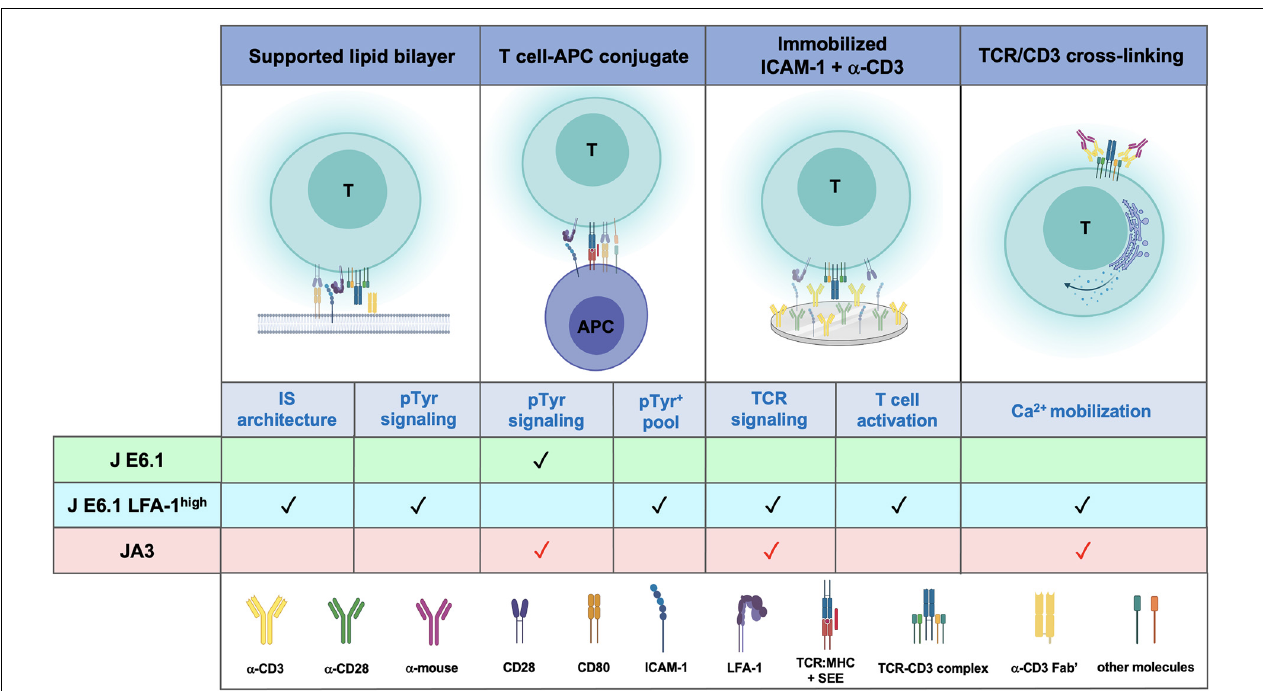
FIGURE 6 | Comparative performance of E6.1, E6.1 LFA-1 high and JA3 cells in IS architecture, TCR signaling and T-cell activation. Schematic representation of experimental settings used for testing the performance of the three Jurkat lines. The symbol “ (cid:88) ” indicates the best responder between E6.1 and E6.1 LFA-1 high cells. The symbol “ (cid:88) ” indicates experimental settings in which JA3 cells are good responders. The figure was generated with BioRender.com.